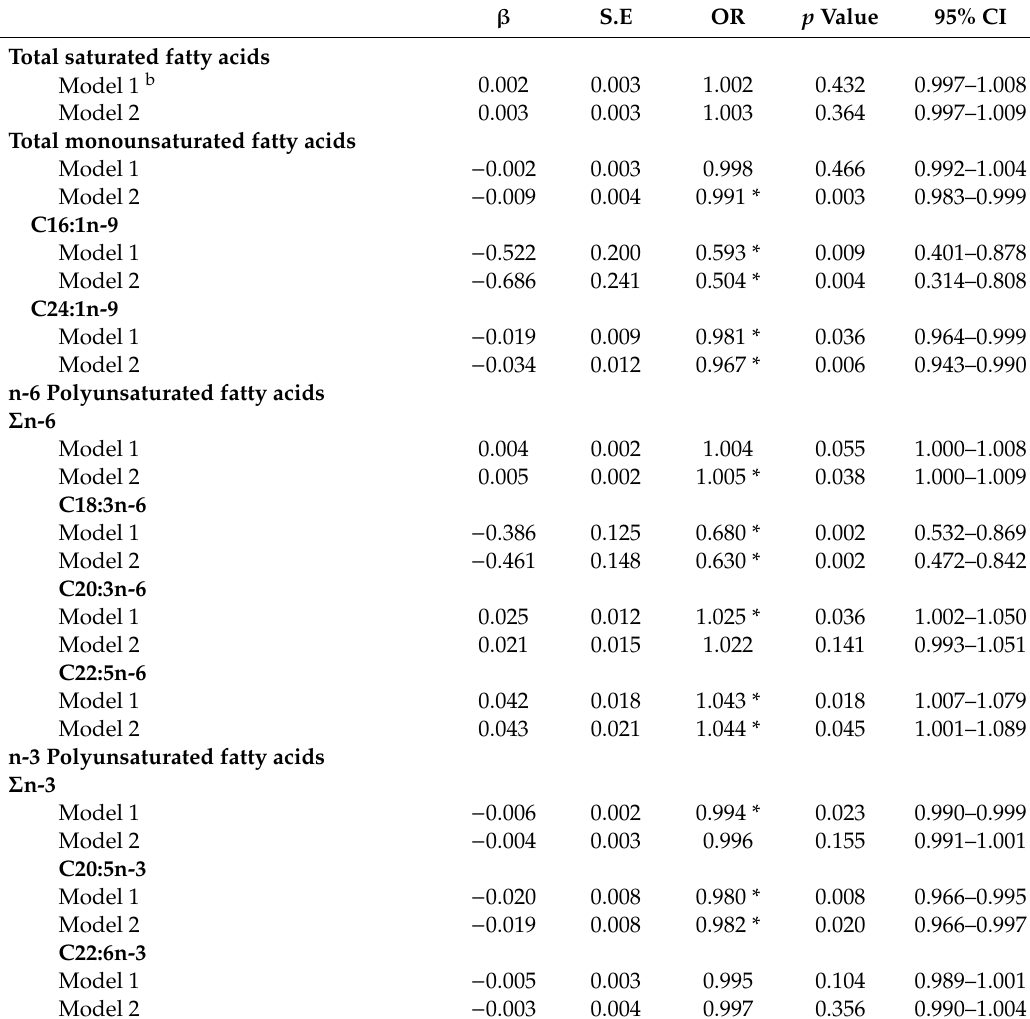
Table 5. Association between fatty acid composition of erythrocyte and postpartum depression a